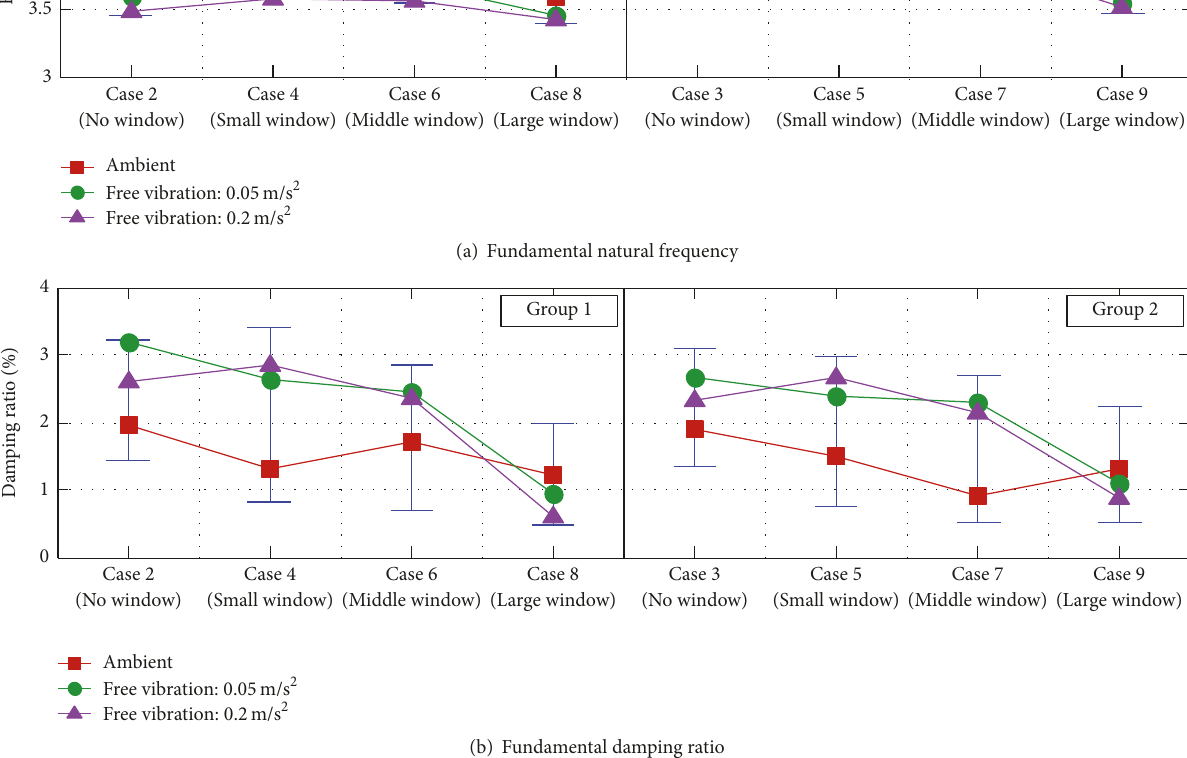
natural frequencies and damping ratios are represented by the average values. The comparison between the results of AVT and FVT shows very little difference for the bare steel